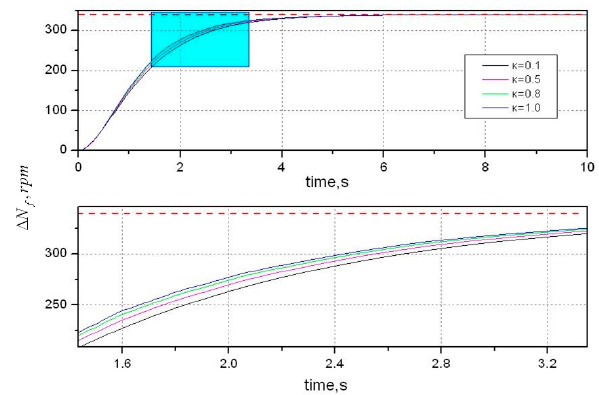
Figure 4. Fan speed response with uncertainty in system parameters. Energies 2017 , 10 , 73